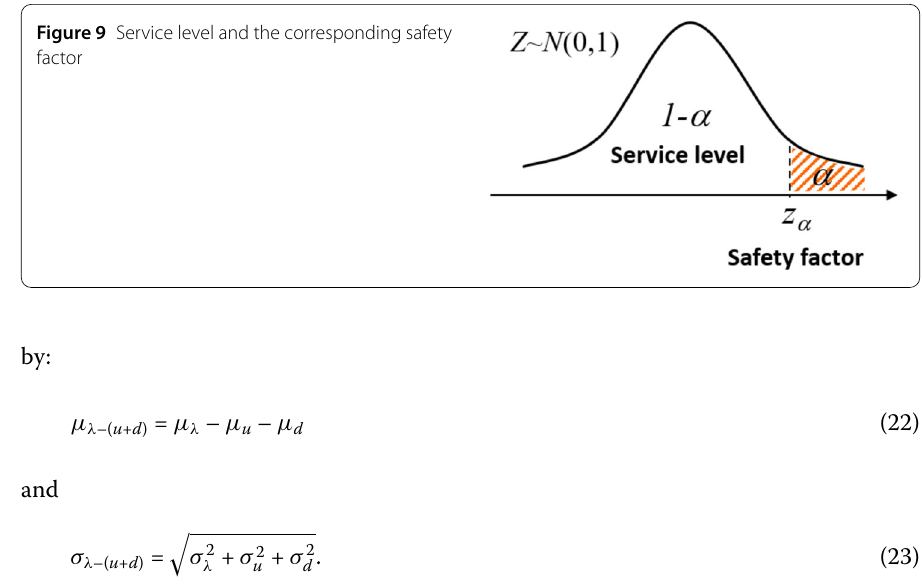
Figure 9 Service level and the corresponding safety